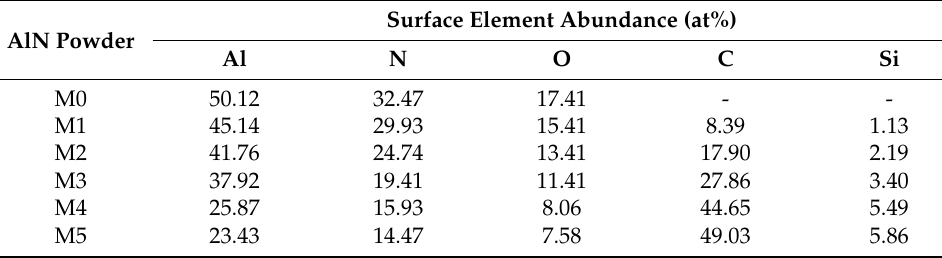
Figure 4. O1s of various OS-modi fi ed AlN powders.